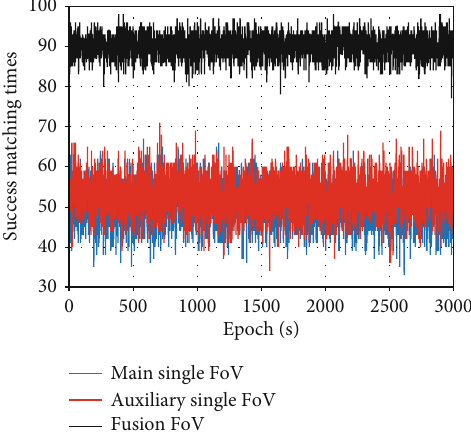
Figure 20: Comparison of dynamic local star catalog and all-sky star